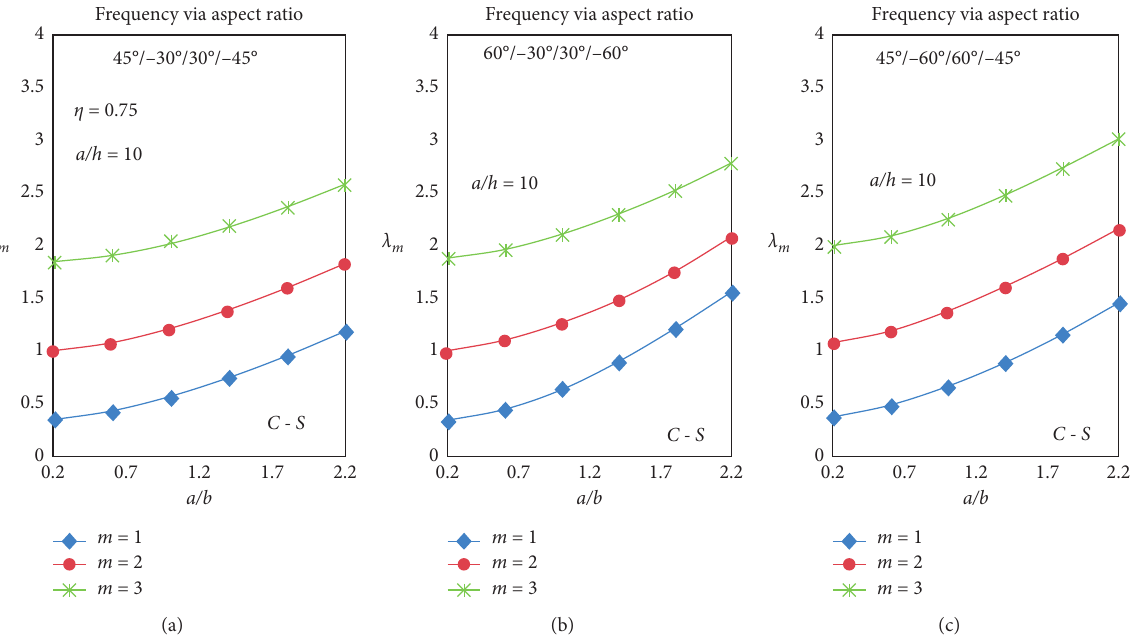
Figure 16: Influence of aspect ratio on frequency parameter value of 4-layered plates under C-S support